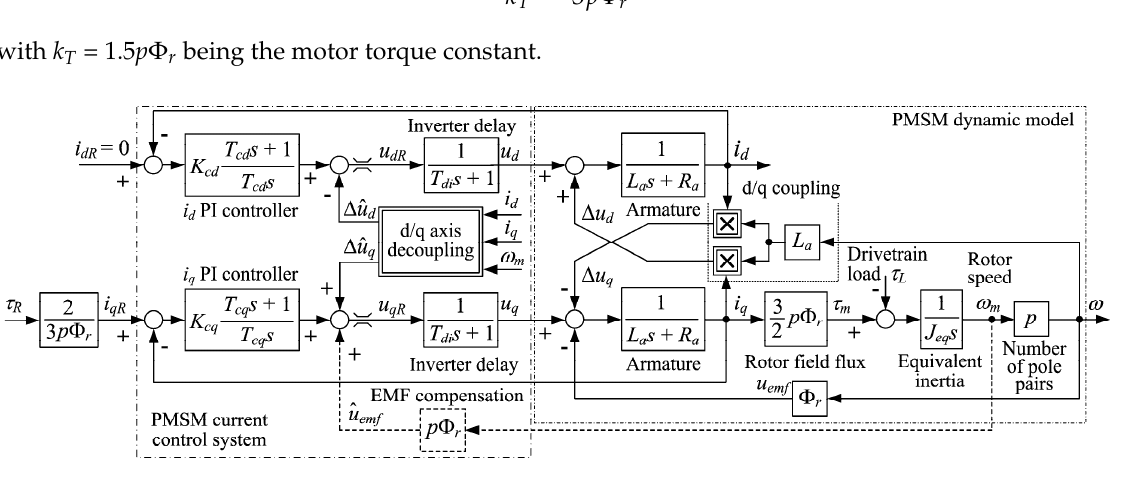
Figure 2. Block diagram of d - q coordinate frame current control system for inverter-fed PMSM traction motor operating below rated speed.